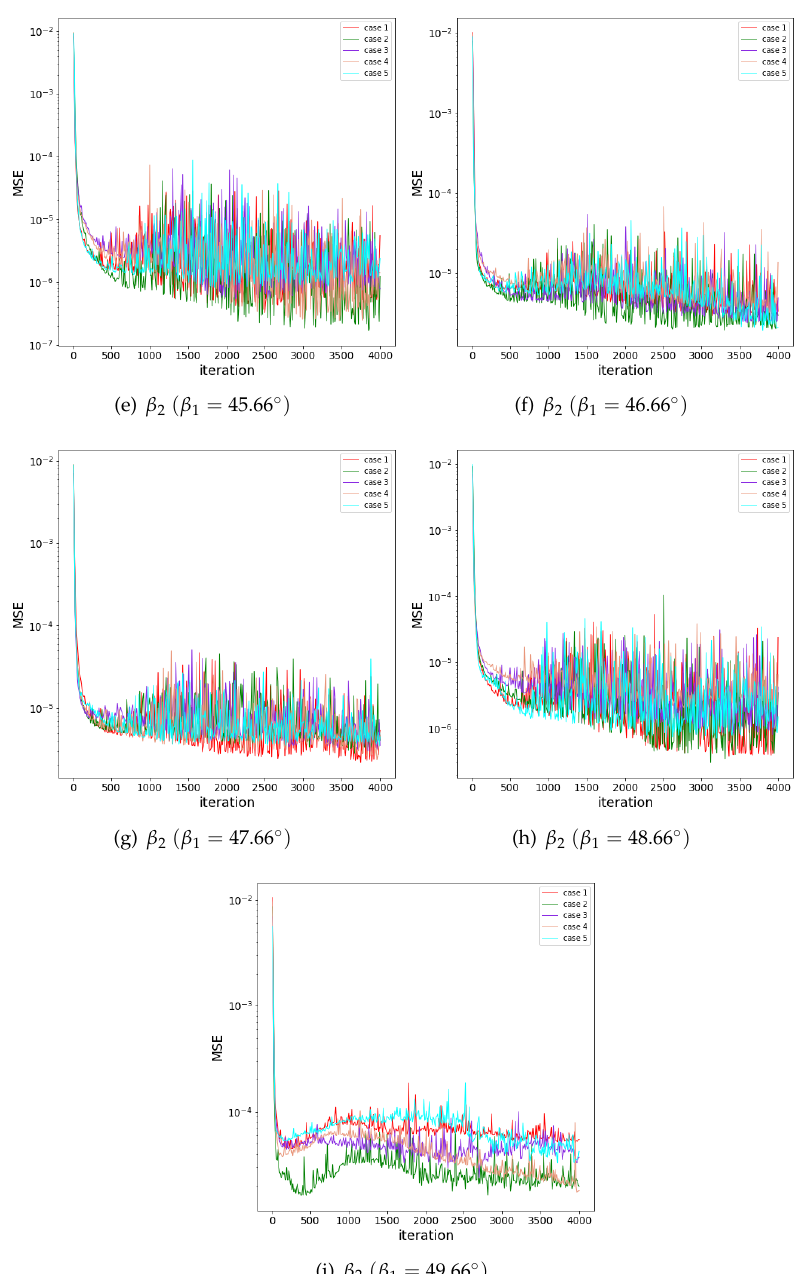
Figure A4. ANN convergence curves of cases with different divisions of train-set and